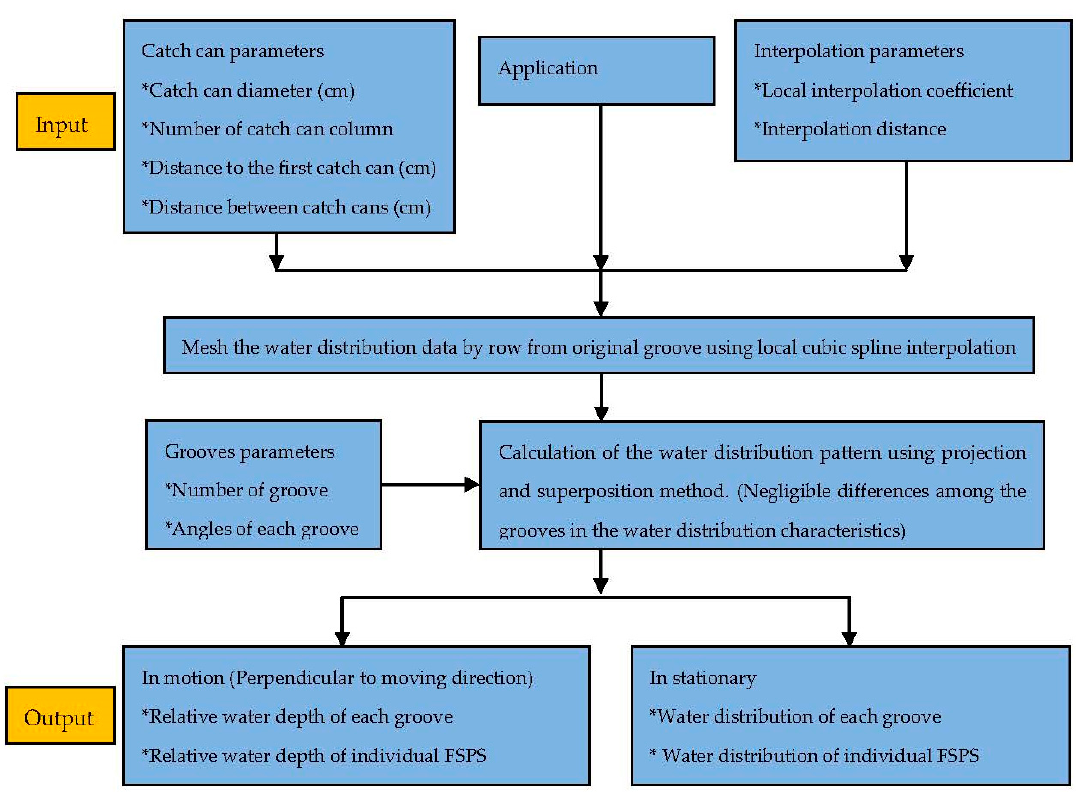
Figure 6. Calculation of water distribution pattern.